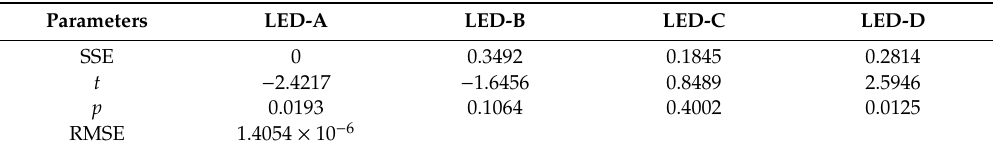
Table 2. Scenario 1. Least squares estimation of PDoP values for received signal strength (RSS) localization. RMSE = root means square errors.